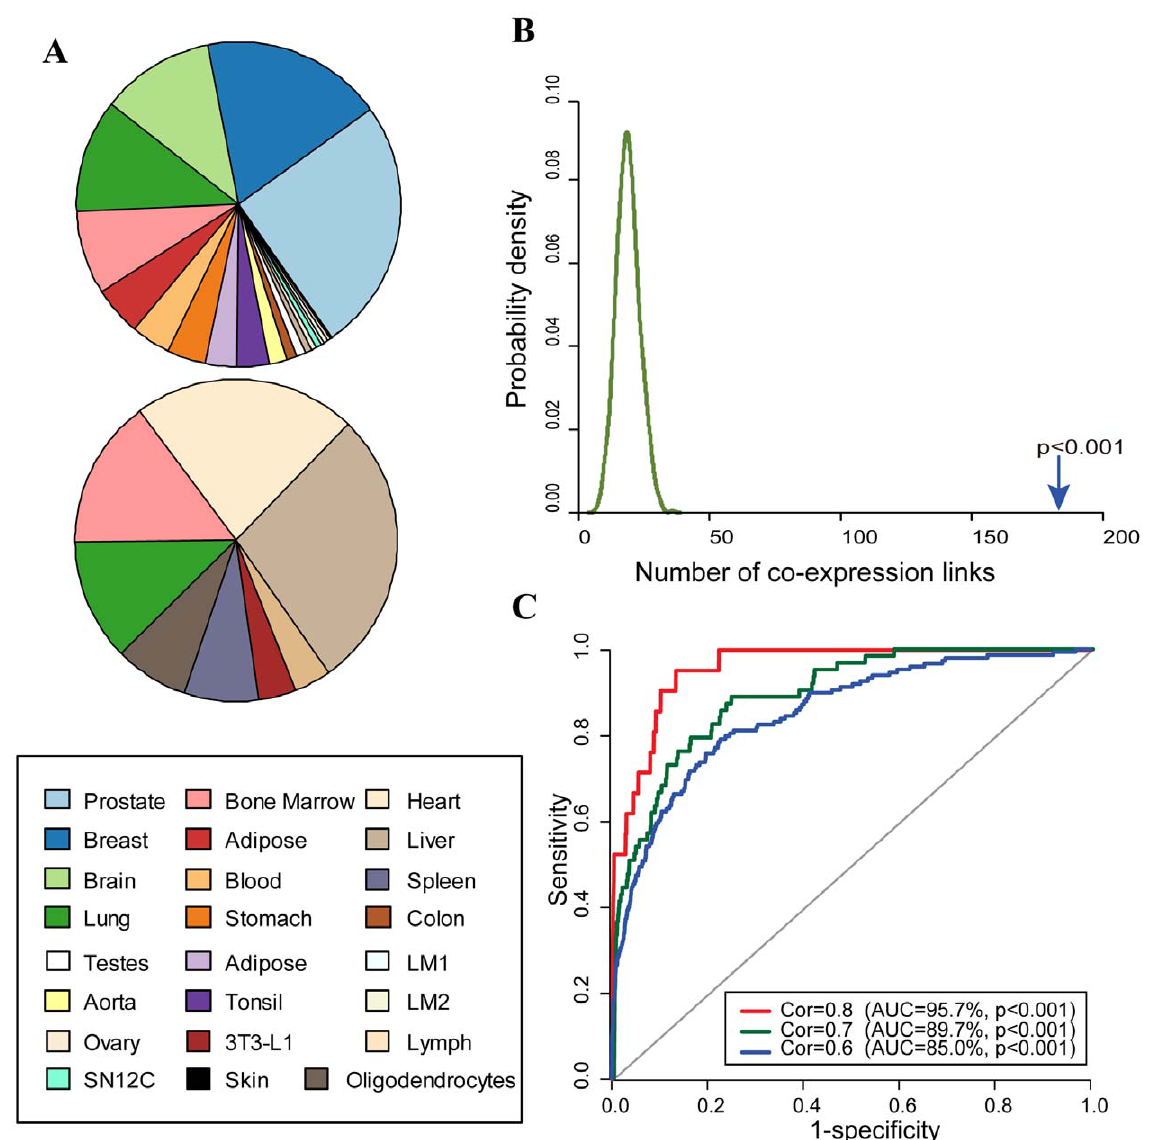
Figure 1. Evaluation of the conserved co-expression relationships. (A) Pie charts of miRNA expression data from human (top) and mouse (bottom) included in the analysis. Colors represent different tissues. (B) Probability density of the number of co-expression links identified through the permutation of orthologous miRNAs. The permutation experiment was repeated 100 times. (C) ROC curves used to quantify the significant of these relationships using a PCR-based miRNA expression data (GSE23024).